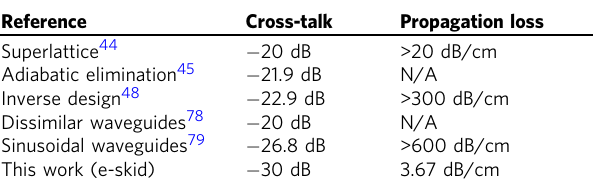
depth (e-skid waveguide) and other dielectric waveguides Reference